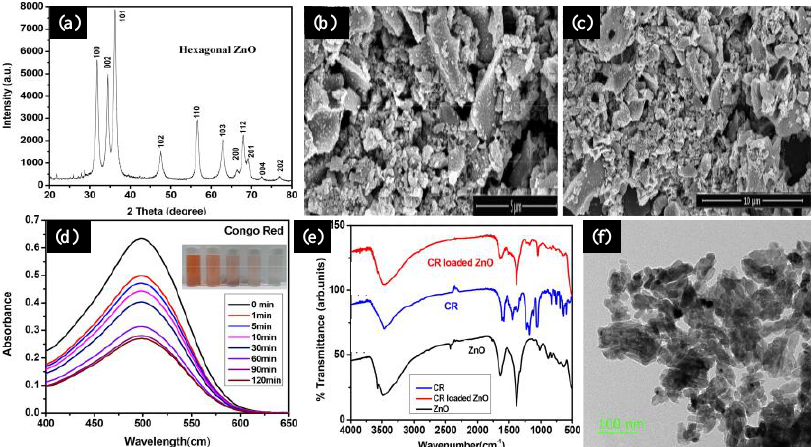
Figure 3. ( a ) X-ray diffraction pattern of the ZnO NPs. ( b , c ) Scanning electron microscopy images of agglomerated ZnO NPs. ( d ) UV–Vis spectra of the Congo red (CR) dye versus time. ( e ) The FTIR spectra of the ZnO NPs, CR dye, and CR–loaded ZnO NPs. ( f ) Transmission electron microscopy of the ZnO NPs at a 100 nm scale. Figure adapted with permission from Reference [39]. Copyright 2020 Elsevier.